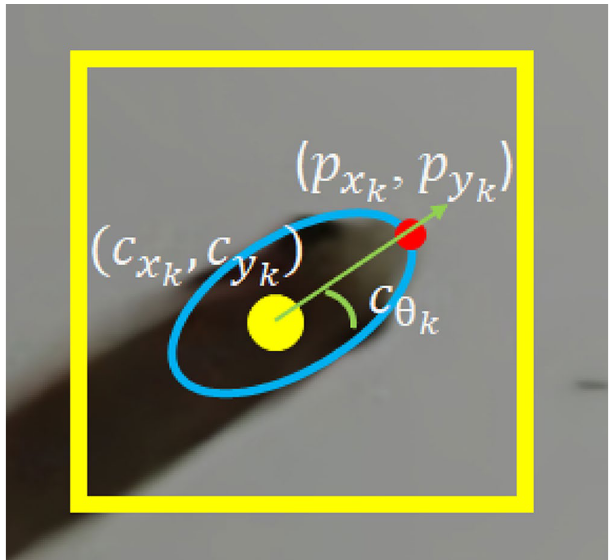
, c y k ) is represented k k